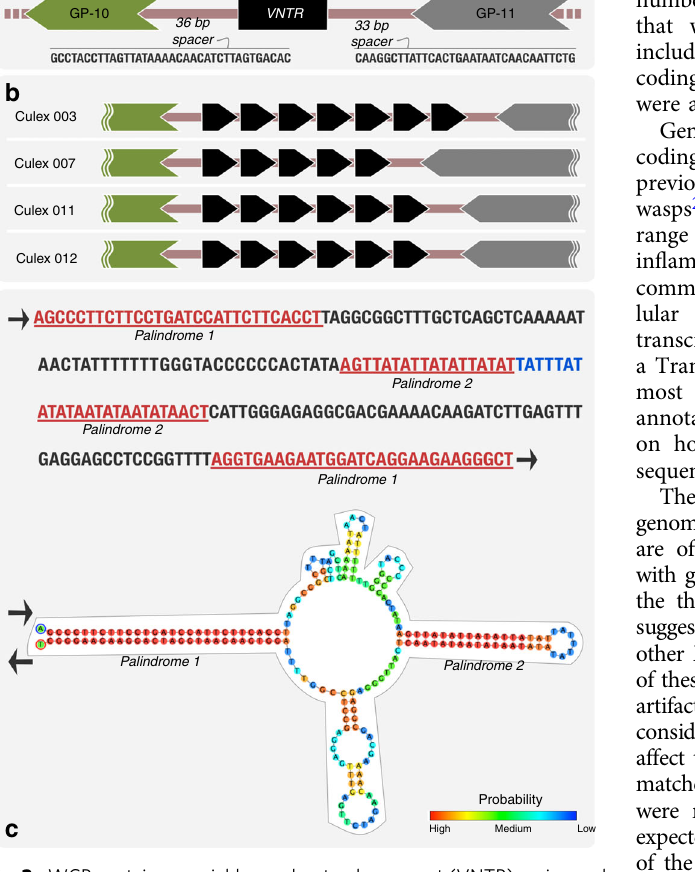
Fig. 3 pWCP contains a variable number tandem repeat (VNTR) region and extragenic palindrome (EP) sequence. a A VNTR region is located between parA and uncharacterized gene in the circular genome. While the number of repeats varies across individuals ( b ), the 36- and 33-bp spacers are conserved. Each black arrow represents a 16-nt repeat. The predicted DNA structure of the EP sequence is illustrated in c where color indicates probability of each base pairing. Red represents the strongest probability, whereas blue is the